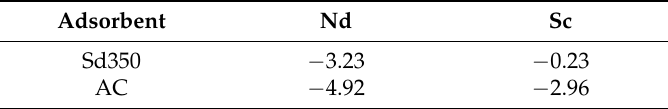
Table 4. ∆ G o (kJ · mol − 1 ) values of adsorption of REEs on Sd350 and